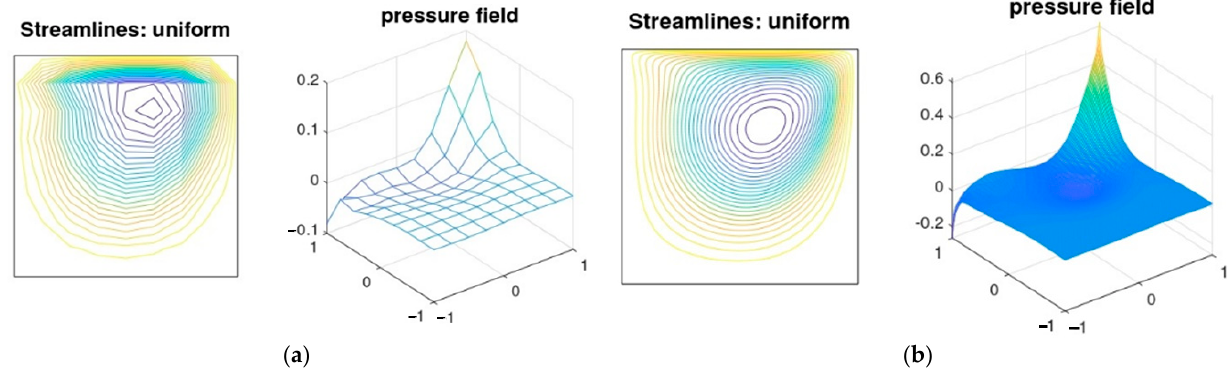
Figure 2. Equally distributed streamline plot associated with a 16 × 16 and 256 × 256 square grid, Q 1 – Q 1 approximation. ( a ) 16 × 16 elements; ( b ) 256 × 256 elements.